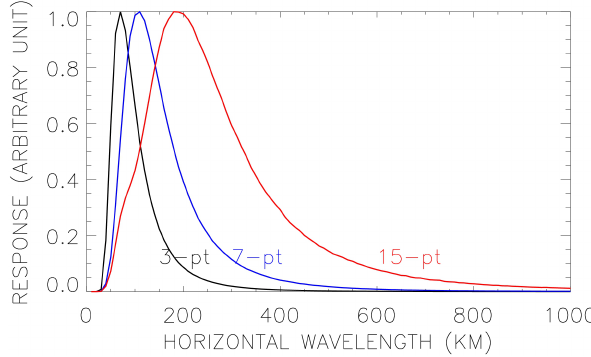
Fig. 2. AIRS visibility as a function of the along-track wavelength with 3-pt (black), 7-pt (blue) and 15-pt (red) running smooth win- dow applied.